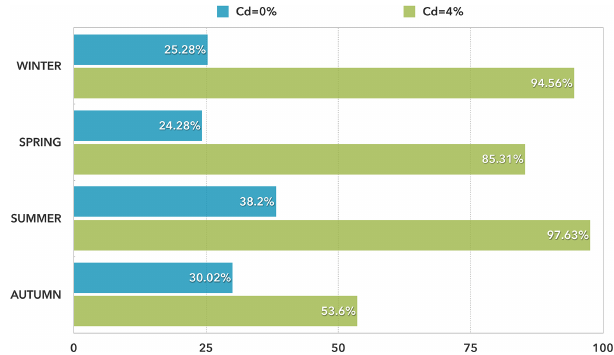
Figure 8. Seasonal numbers of beached particles parameterized with C d = 0% and C d = 4% after 168h of